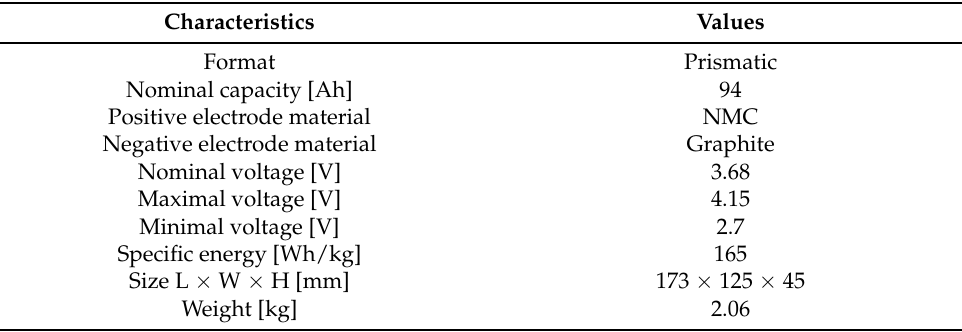
Table 1. Samsung SDI 94Ah main characteristics. Data from [35]. Characteristics